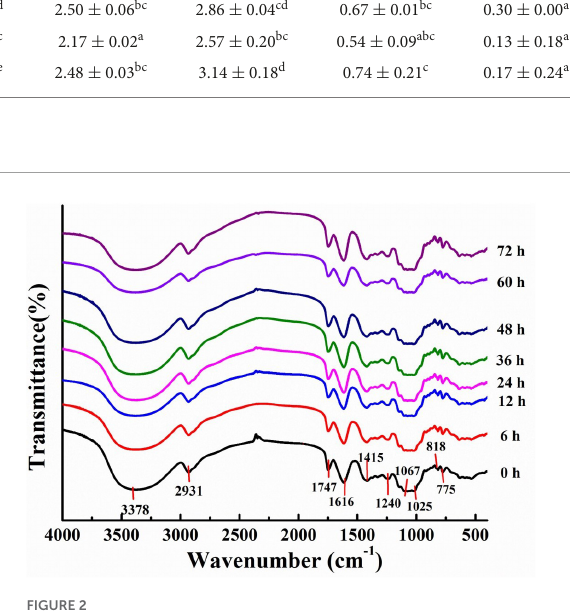
FIGURE2 Fourier Transform Infrared (FT-IR) spectra for polysaccharides derived from litchi pulp fermented with Lactobacillus fermentum for different